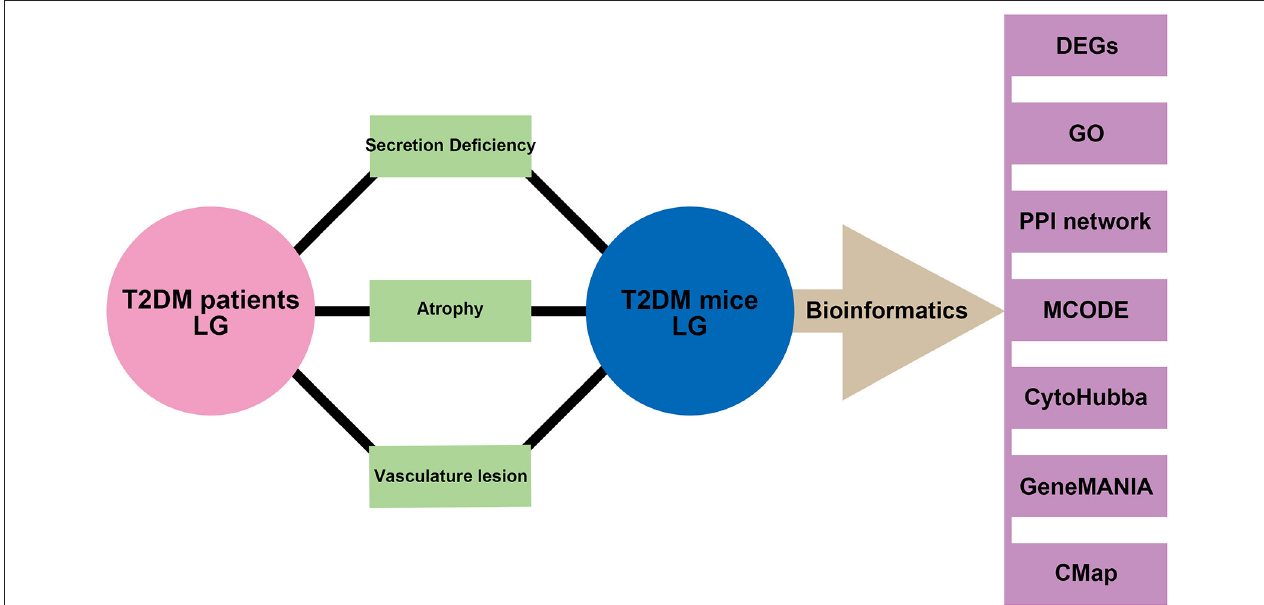
FIGURE 1 | Schematic diagram of the study. Phenotypes of secretion deficiency, atrophy, and vascular lesion were both found in the lacrimal gland from patients with type 2 diabetes and mice model. Bioinformatics of samples from the mice model was performed to further identify the potential biomarkers and